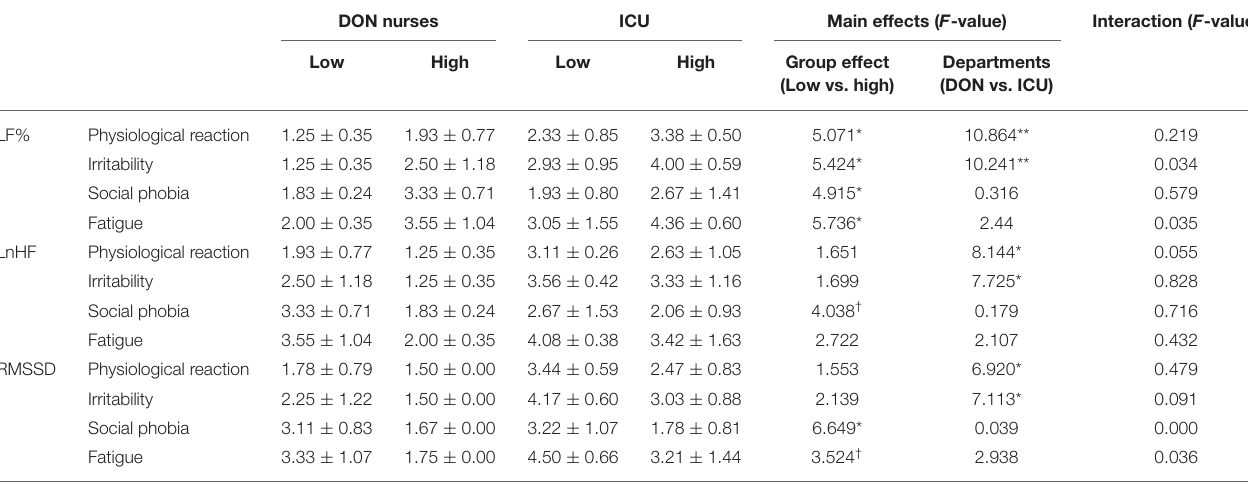
TABLE 7 | Mean differences of CNSRS subscale for HRV parameters and department ( N =